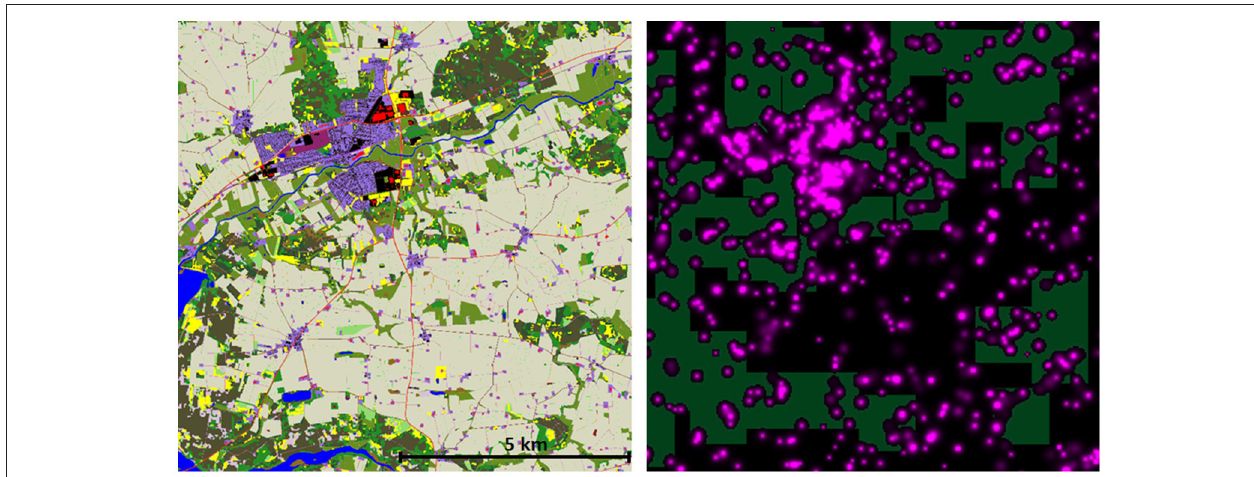
FIGURE 3 | Map of the Bjerringbro landscape (left) and an AR exposure map from September 30th for Scenario 2 (present day). Colored areas indicate modeled AC environmental concentration on this day. Note the distribution of AR does not allow for placement of the M. nivalis territories shown as light rectangles without covering one or more AR locations. See also Supplementary Material for a time-series of this data as a video showing the spatio-temporal dynamics of AR availability in the landscape.